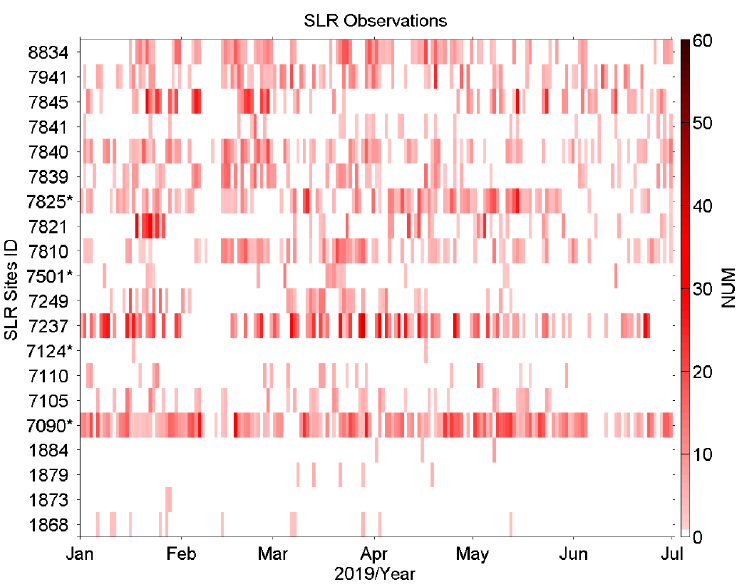
Figure 3. The contribution of each SLR site to the daily SLR observations of all BDS satellites.